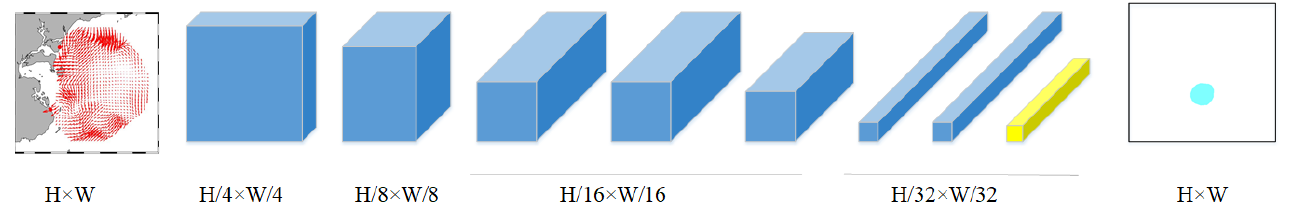
Figure 6. CDEDNet-2: Architecture with Parameter-based Transfer Learning. The 8 blue cuboids correspond to 8 convolution layers. The leftmost map is the original current field. The rightmost map is the predicted eddy mask by CDEDNet-2.